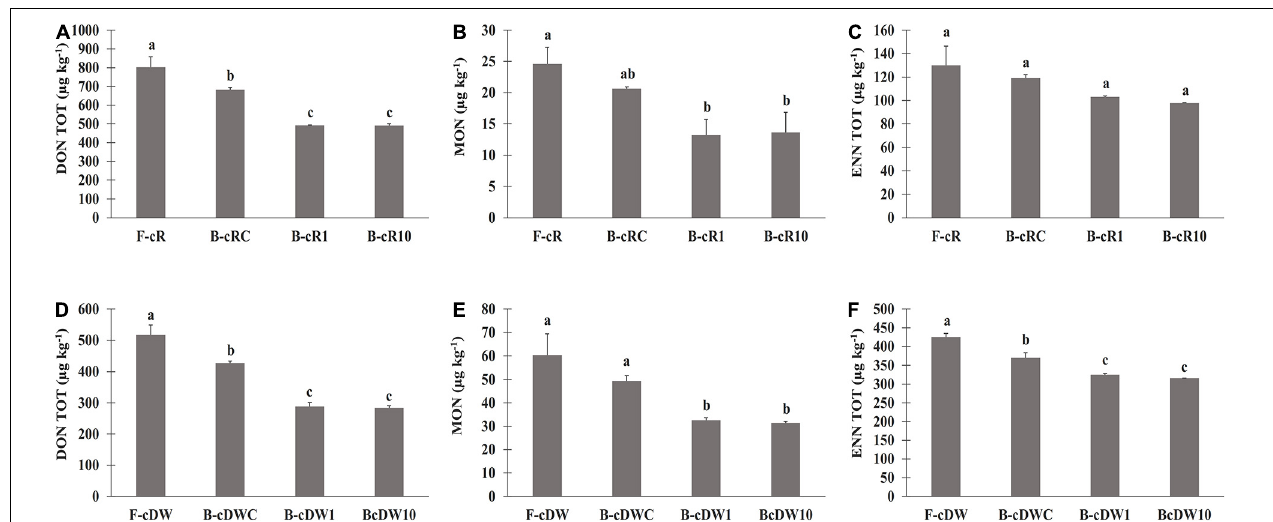
FIGURE 3 | Mycotoxin levels in breads prepared with the sourdoughs obtained after the first fermentation (B-cR1 and B-cDW1) and those after 10 days of propagation (B-cR10 and B-cDW10). The sourdoughs were used as leavening agent at 15% and 40% (w/w) in wheat (DY, 160) and rye (DY, 180) breads, respectively. Lactiplantibacillus plantarum oR4 and DW9 strains were used as binary starters in association with Pediococcus acidilactici oSW5 to ferment conventional rye (oR4 and oSW5) and durum wheat (DW9 and oSW5) flours depending on the source of isolation of L. plantarum strains. Saccharomyces cerevisiae N2 was used as yeast in all samples. Bacteria and yeast were inoculated at final cell density of circa 7 and 6 log10 cfu/g, respectively. The first fermentation (t1) was carried out at 25 ◦ C for 24 h and propagation, through back-slopping (25 ◦ C for 5 h), and lasted 10 days. Panels (A–C) DON, MON and ENN levels in rye breads: Panels (D–F) DON, MON and ENN levels in durum wheat